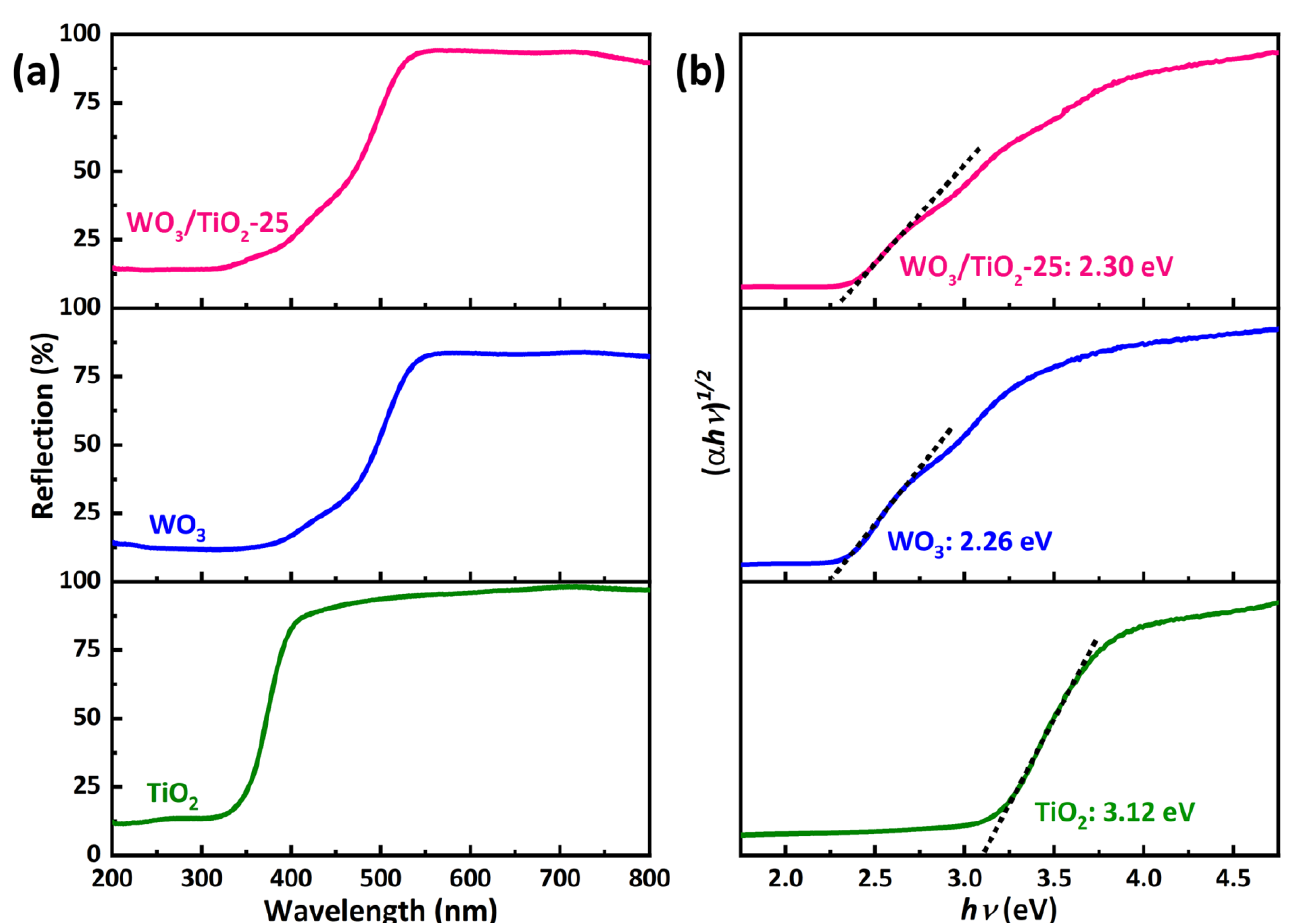
Figure 4. ( a ) Diffuse reflectance spectra for the TiO 2 nanoribbons, WO 3 nanosheets, and WO 3 /TiO 2 -25 heterojunction. ( b ) Plot of (αhν) 1/2 as a function of photon energy (hν).